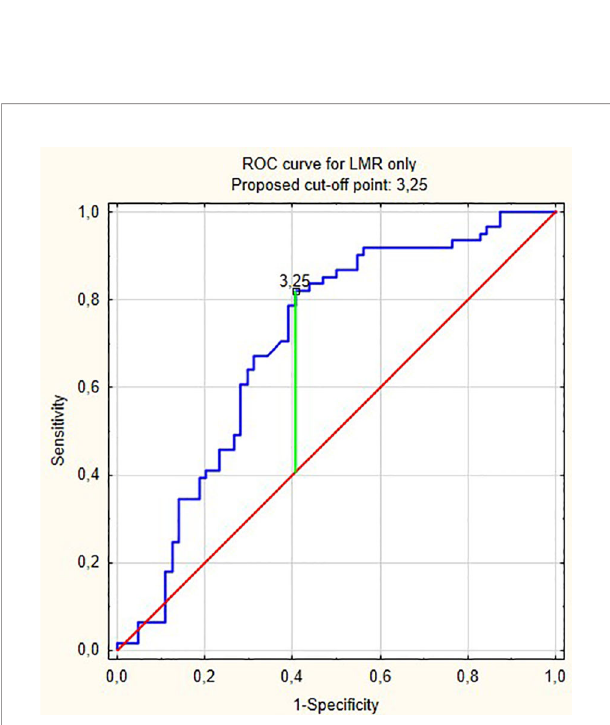
FIGURE 4 | ROC curve for LMR only. Proposed cut-off point: